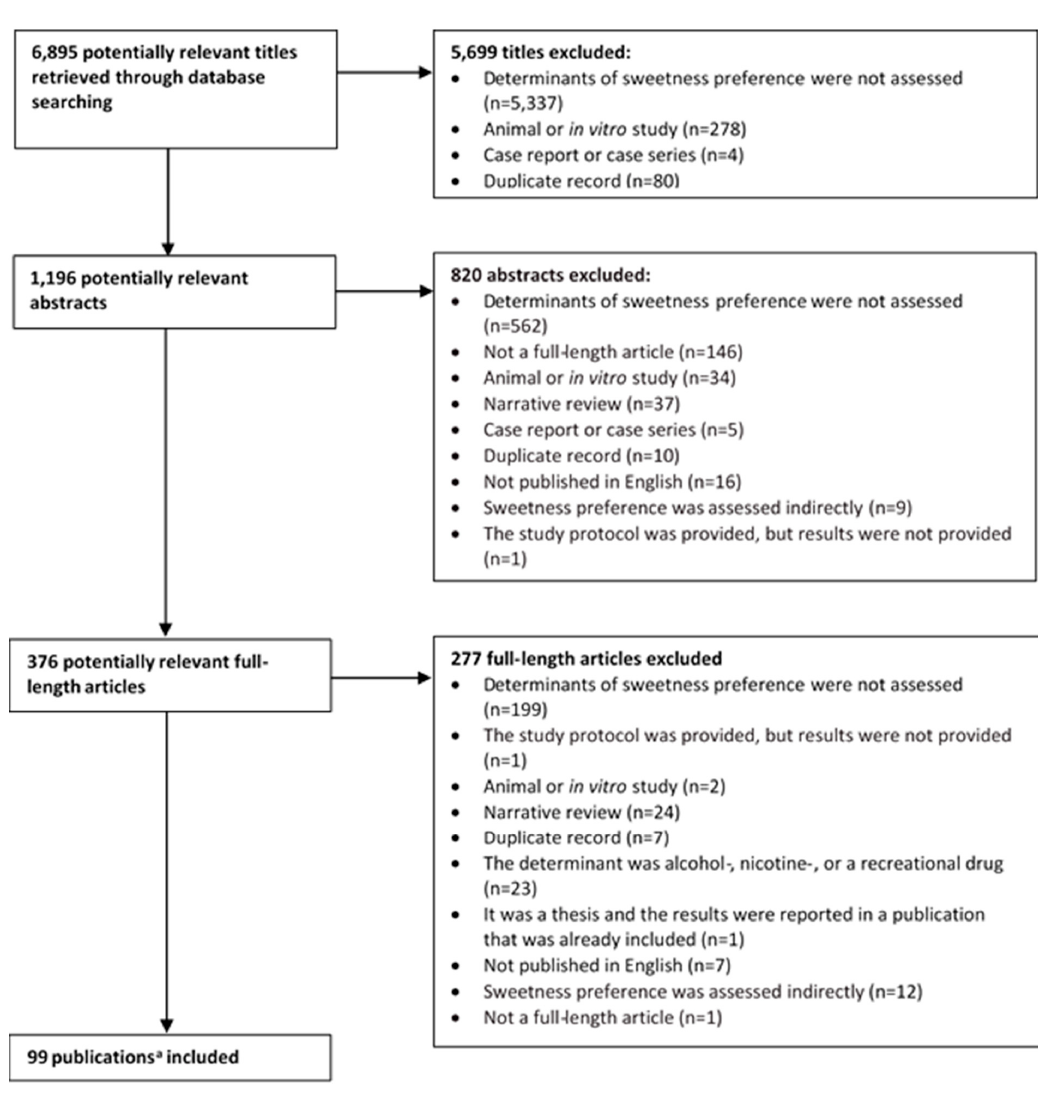
Figure 1. Flowchart of the literature search process. a Two of the publications [23,24] were considered “kin studies” (i.e., the studies were conducted using the same population of individuals, and outcomes were assessed at the same time point, but di ff erent outcomes were published in di ff erent manuscripts). Therefore, 98 unique studies (99 publications) are